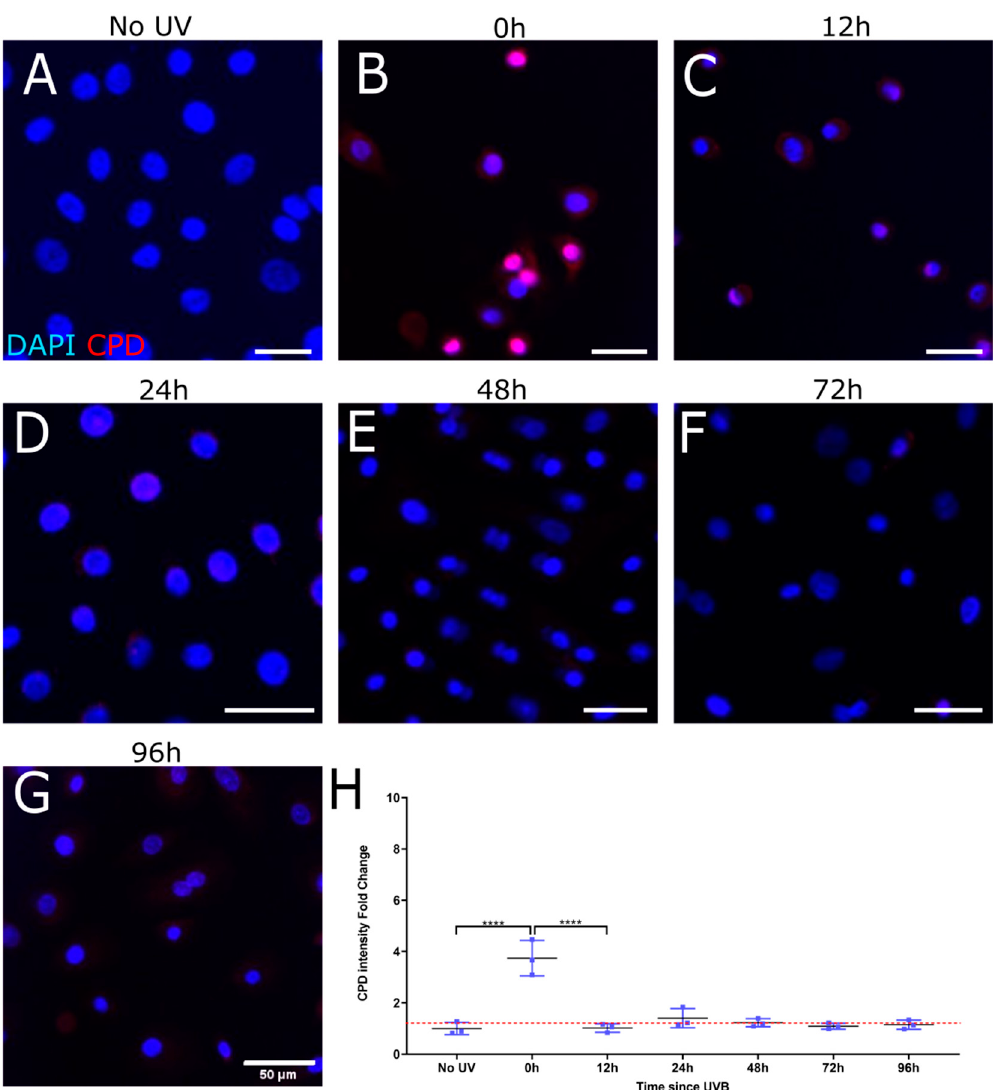
Figure 3. Representative immunofluorescence images illustrating recovery of induced CPD in HLE following UVB exposure and T4 endonuclease V treatment. Merged images show nuclei stained blue (DAPI) and CPDs stained red. Mean fluorescence measurements were tracked over the course of 96 h after 0.03 J/cm 2 UVB ( B – G ). A non-irradiated control was used for comparison ( A ) and to set a baseline when quantifying fold change in CPD immunofluorescence ( H ). CPD immunofluorescence was highest at 0 h (**** for p < 0.001) ( B ). Each data point was analyzed from 3 donors, each giving 3 images of over 500 cells per image.